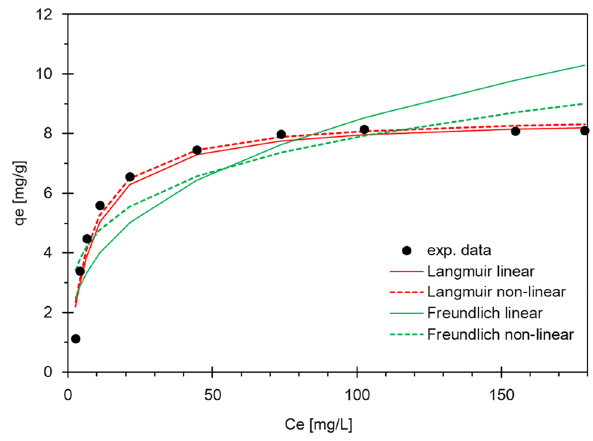
Figure 2. Isotherm models for biosorption onto Eclipta alba powder.